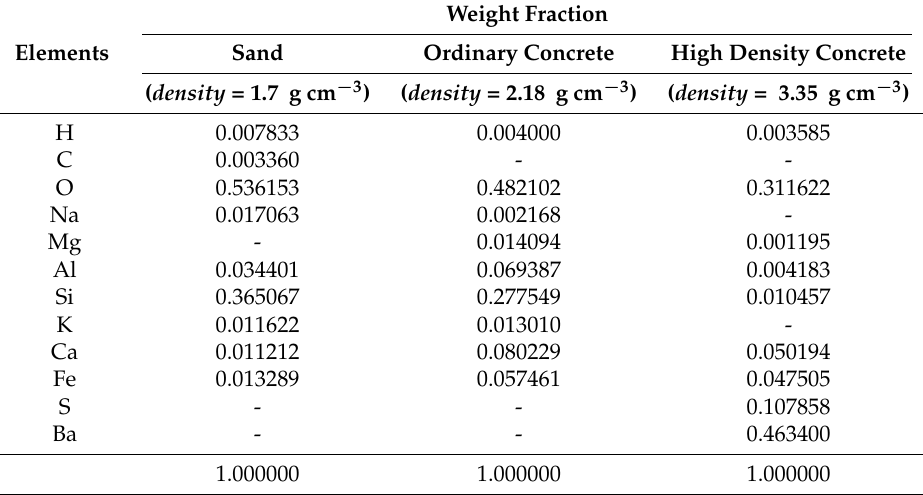
Densities and elemental composition of the three materials used in the simulation. The information was obtained from